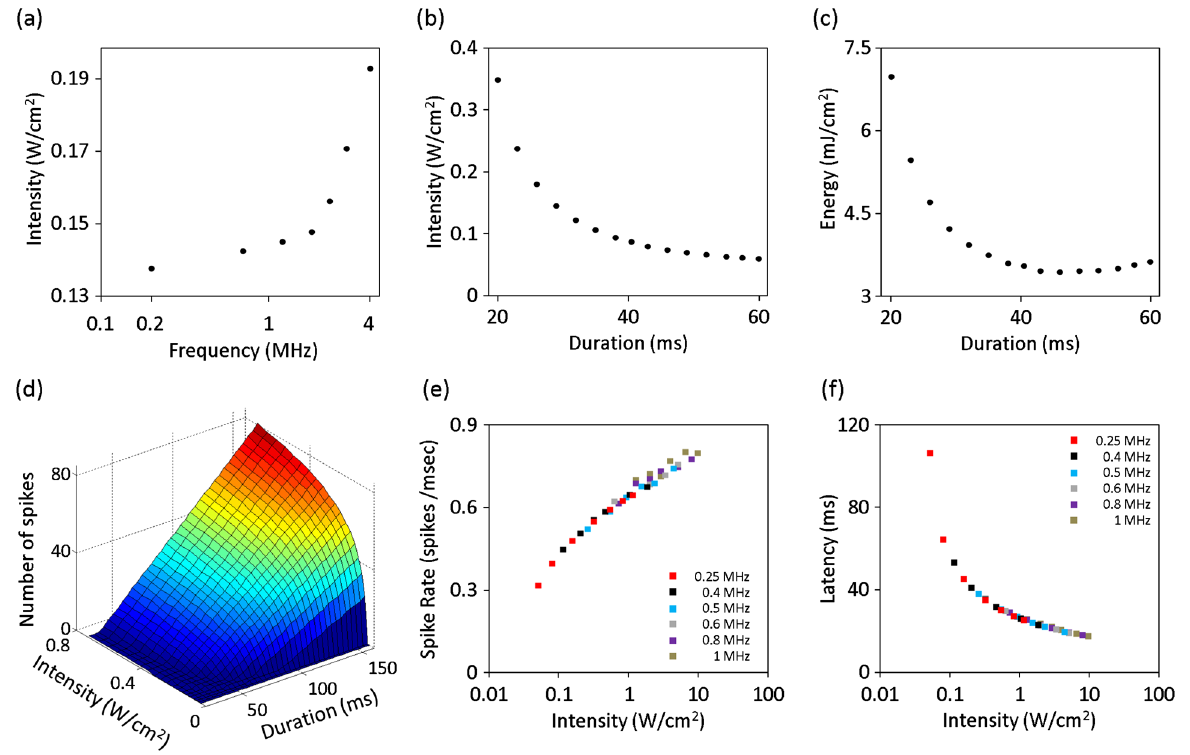
FIG. 3 (color online). Relationship between US stimulus parameters and APs generation in NBLS model. (a) Threshold intensity versus frequency required to generate a single AP (duration: 30 ms). (b,c) Threshold intensity and energy per unit membrane area versus stimulus duration required to generate a single AP (frequency: 0.35 MHz). (d) The number of APs induced by US stimuli as a function of US intensity and stimulus duration (frequency: 0.35 Mhz). (e) Spike rate versus intensity for US frequencies (in MHz) of 0.25 (red squares), 0.4 (black squares), 0.5 (blue squares), 0.6 (gray squares), 0.8 (purple squares) and 1.0 (brown squares). (f) Latency before the appearance of the first AP during the US stimulation versus US intensity. Symbols and colors as in ð e